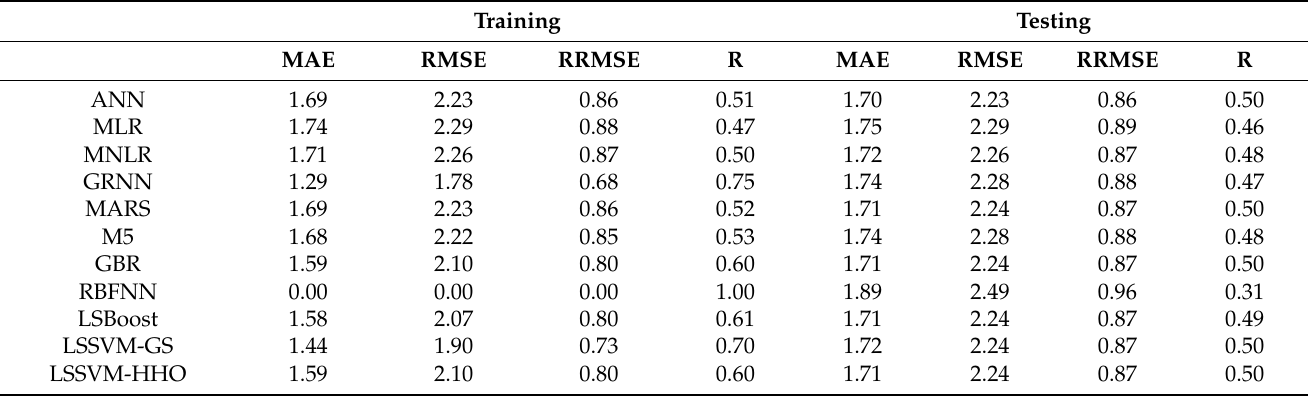
Table A12. Results of modeling WS with base algorithms in the Khor Birjand station.